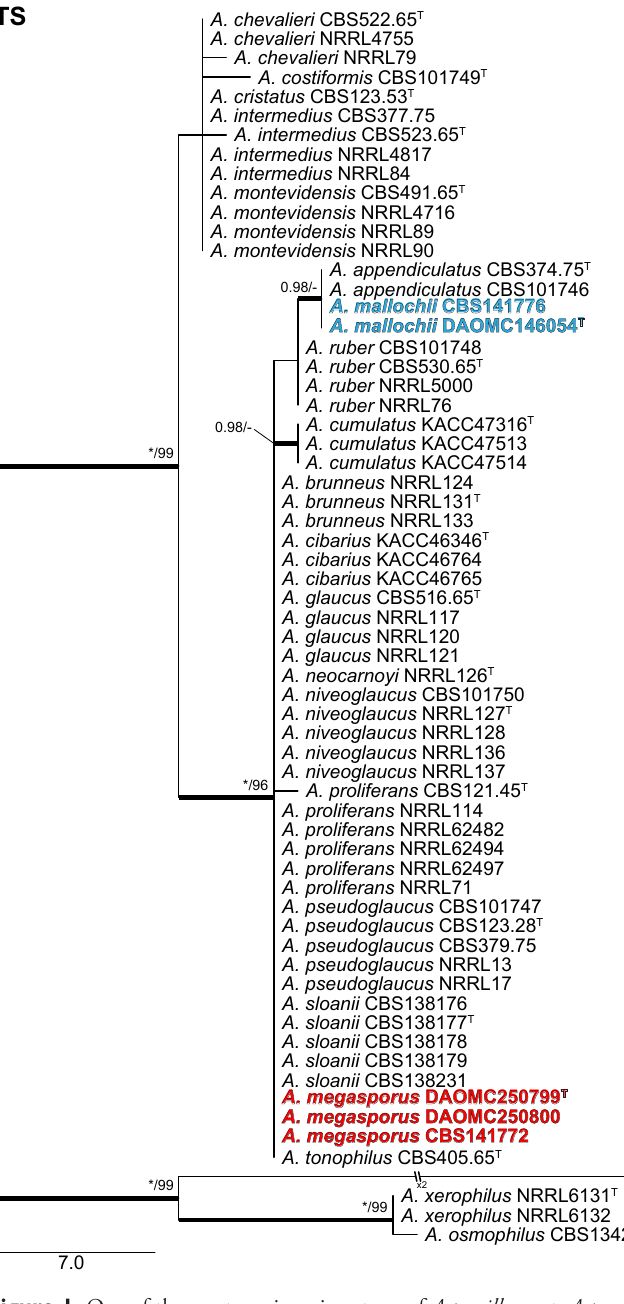
Figure 1. One of the most parsimonious trees of Aspergillus sect. Aspergillus based on ITS, CaM , BenA and RPB2 . Trees were rooted to A. xerophilus , A. leucocarpus and A. osmophilus . Support in nodes higher than 80% bootstrap values and 0.95 posterior probabilities are shown above thickened branches. New species are shown in bold and colour, while ex-type strains are followed by T